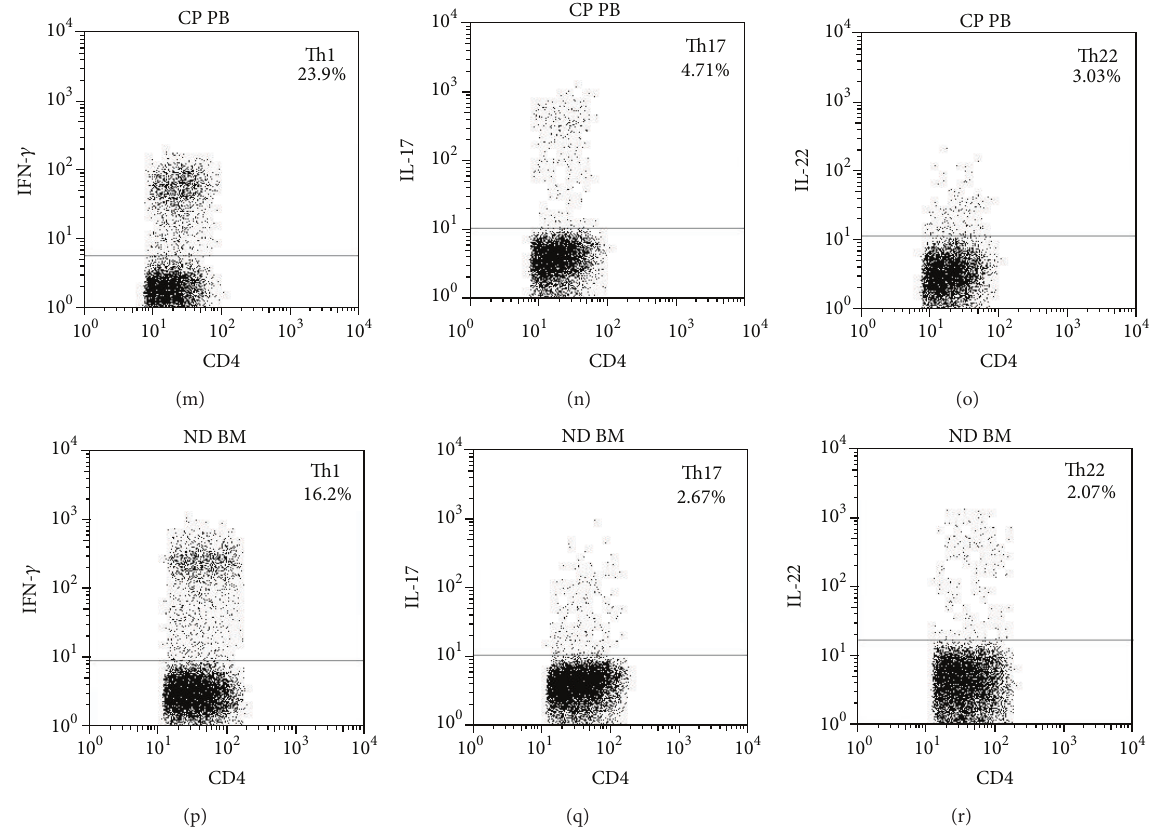
Figure 1: PB and BM percentages of Th1, Th17 and Th22 cells in representative ND patients, CP-CML patients, and healthy controls. (a, b, c) Representative FACS dot plots of Th1 (CD4 + IFN-r + ), Th17 (CD4 + IL-17 + ), and Th22 (CD4 + IL-22 + , IL-17 − , and IFN 𝛾 − ) cells in BM of ND CML patients. (d, e, f) Representative FACS dot plots of Th1, Th17, and Th22 cells in BM of CP-CML patients. (g, h, i,) Representative FACS dot plots of Th1, Th17, and Th22 cells in BM of healthy controls. (j, k, l) Representative FACS dot plots of Th1, Th17, and Th22 cells in PB of ND CML patients. (m, n, o) Representative FACS dot plots of Th1, Th17, and Th22 cells in PB of CP-CML patients. (p, q, r) Representative FACS dot plots of Th1, Th17, and Th22 cells in PB of healthy